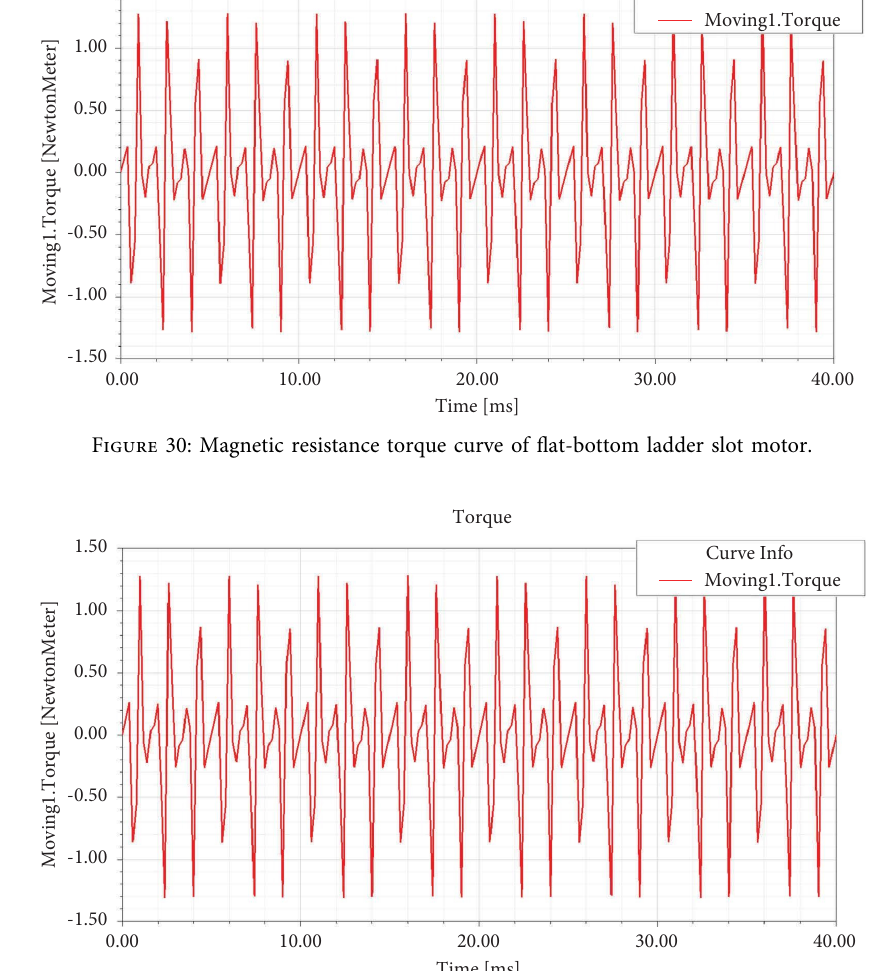
Figure 31: Magnetic resistance torque curve of fat-bottom circular slot motor.